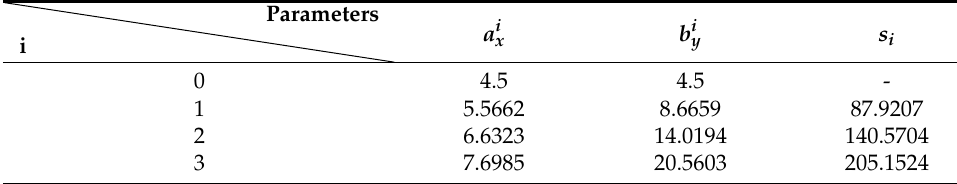
When T = 554 N, the correction results of normal forces are as shown in Table 5. Table 5. Normal forces of discrete areas of translation method ( T = 554 N, n = 3). Normal Forces